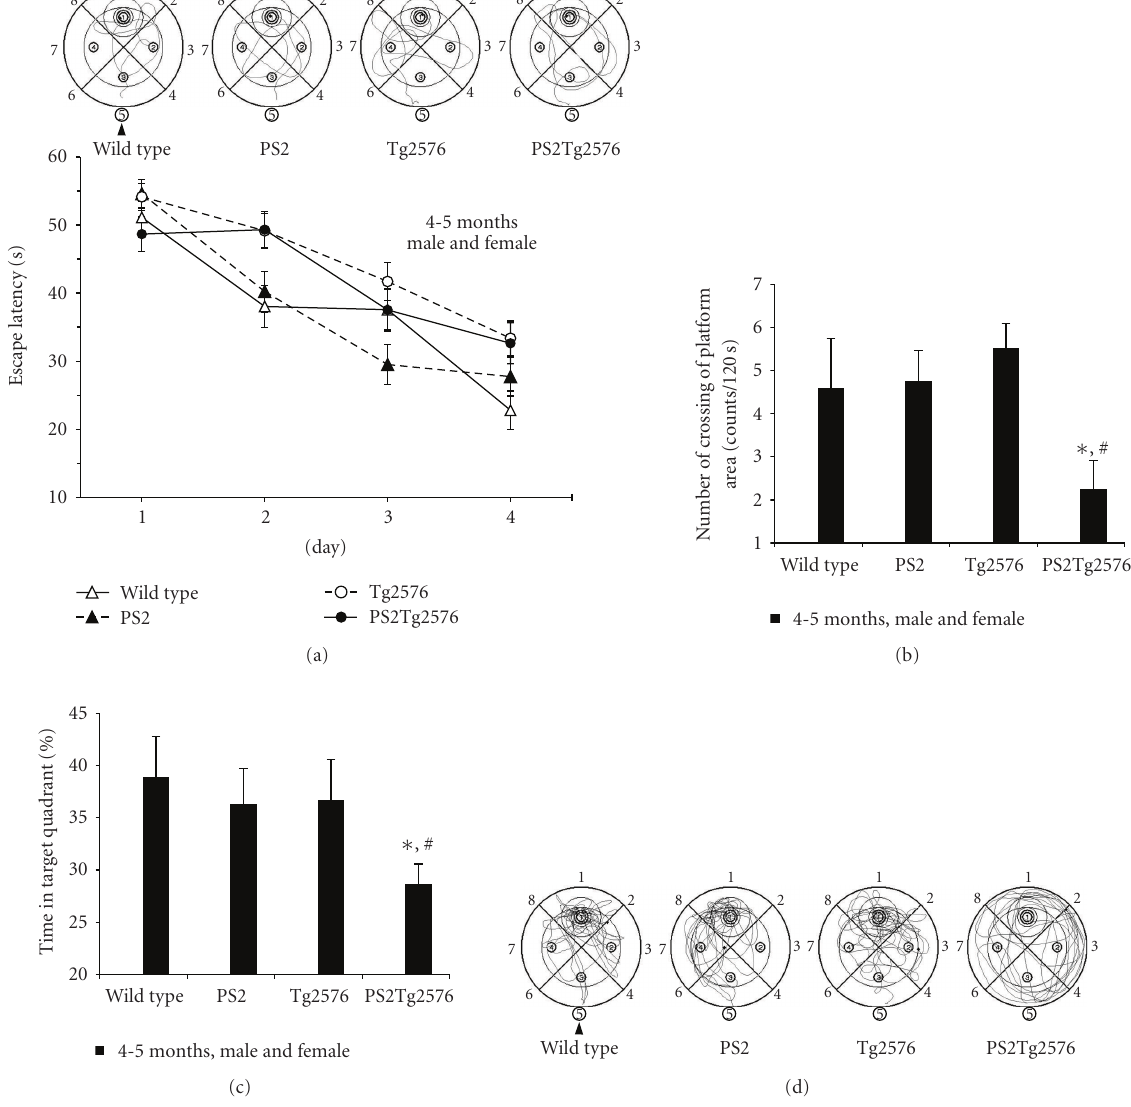
Figure 3: Morris water maze performed at 4-5 months of age of PS2Tg2576 mice. (a) The escape latency of 4-5-month-old mice in the hidden platform trial. Training trials were repeated for 4 days (1 minute/trial, 4 trials/day). The graph shows representative swimming paths of individual mice on day 4 of the training phase. (b) The number of crossings of the removed-platform area in the probe test. A probe trial, in which the platform was removed, was performed for 2 minutes on the day after the training trials had finished. (c) Percentage of time spent in the target quadrant during the probe trial. (d) Representative swimming paths of individual mice during the probe test in the training phase. The arrowhead represents the entry point. Values represent the mean ± s.e.m. ( n = 12-24, female and male mixture). Statistical significance was assessed using the unpaired T -test (c, d): ∗ P < . 05 compared with the wild-type mice at the same age; # P < . 05 compared with the Tg2576 mice at the same